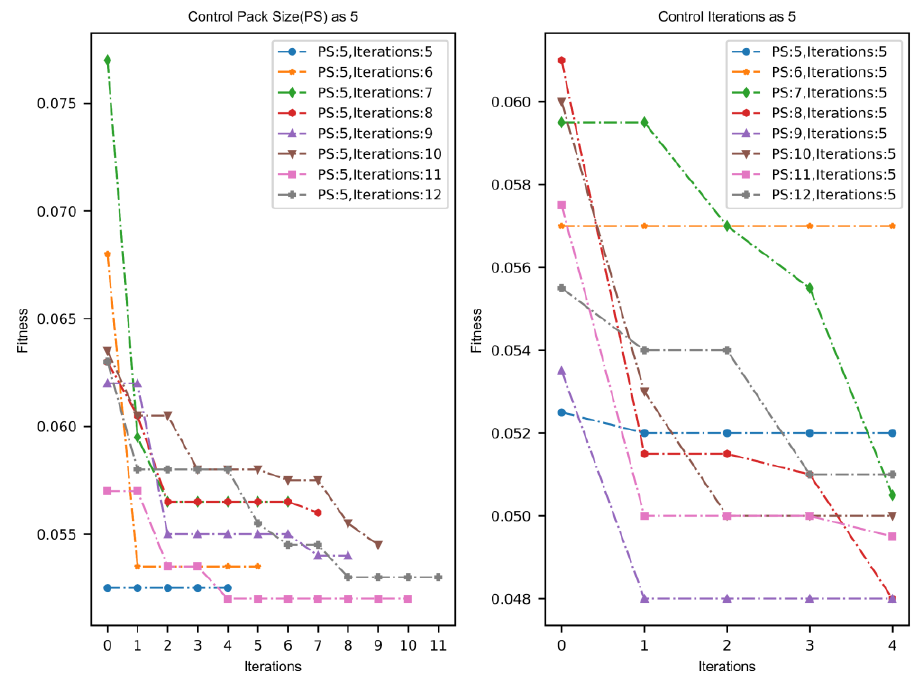
Figure 8. The fitness variation of the model with the increment of iterations by setting different hyperparameters. The left one denotes controlling the grey wolf pack size to 5, the right one denotes controlling the iterations to 5.